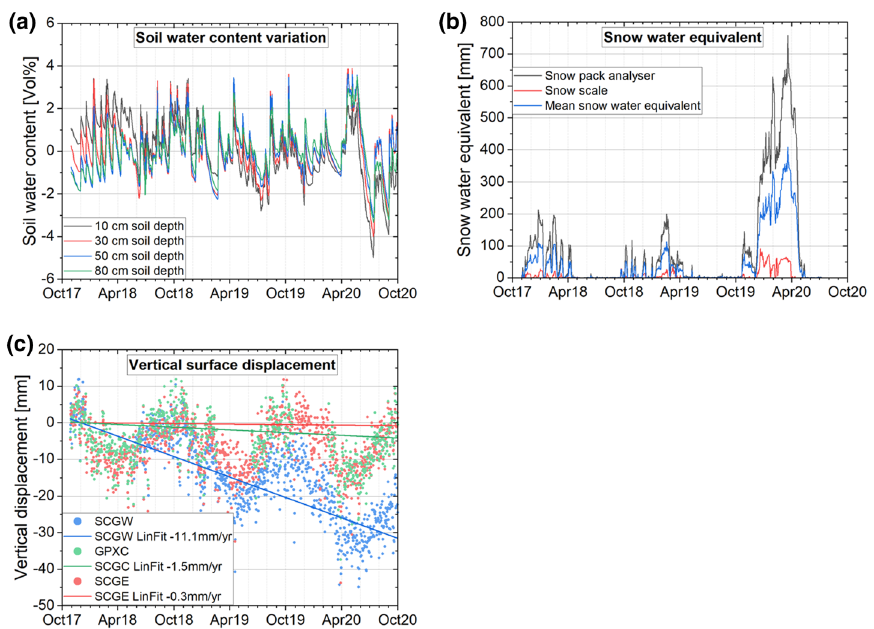
Fig. 3 Environmental observations at Þeistareykir between November 2017 and October 2020, including a soil water content variations at different depths, averaged from soil moisture measurements at the three Þeistareykir gravity stations, b snow water equivalent observed from snow pack analyser and snow scale at SCGE, and c vertical surface displacement observed from continuous GNSS measurements at the three gravity stations and linear approximations; data gaps in the GNSS records (Dec. 2017 to May 2018 for SCGW, Feb. 2019 to June 2019 and Oct. 2019 to Feb. 2020 for SCGC) are due to receiver malfunctions